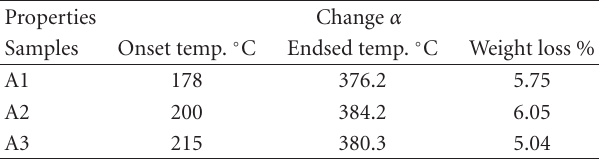
Figure 9: Relation between retained elongation at break and aging time for NBR vulcanizates containing PBN, NR-graft- o -AP, and control vulcanizate. Table 2: Characterization of change α .